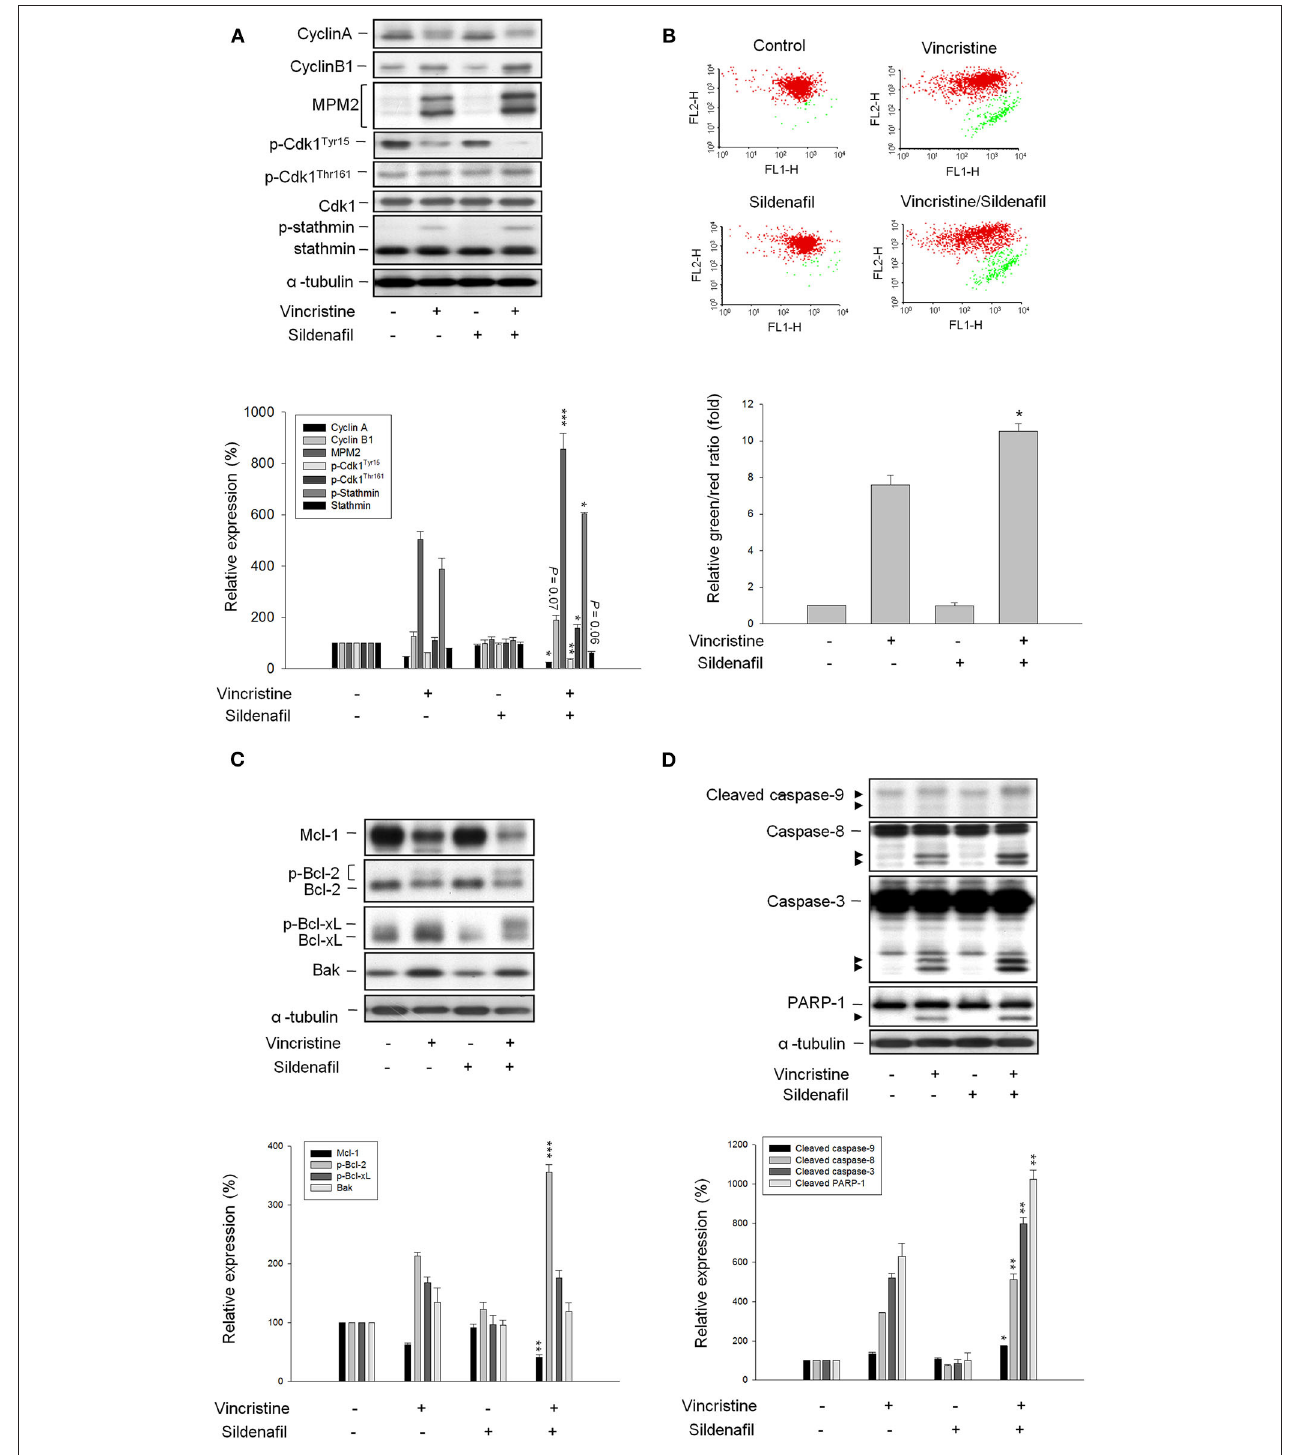
FIGURE 2 | Effect of vincristine and sildenafil on cell-cycle regulators and mitochondria-involved signaling pathway. PC-3 cells were treated in the absence or presence of vincristine (10nM) and sildenafil (10 µ M) for 24h (A,C,D) or 48h (B) . After the treatment, the cells were harvested and lysed for the detection of protein expressions of cell-cycle regulators (A,C,D) by Western blot analysis or the cells were harvested for JC-1 staining to detect mitochondrial membrane potential using FACScan flow cytometric analysis (B) . Data are expressed as mean ± SEM of three to six determinations. * P < 0.05, ** P < 0.01, and *** P < 0.001 compared with vincristine alone.